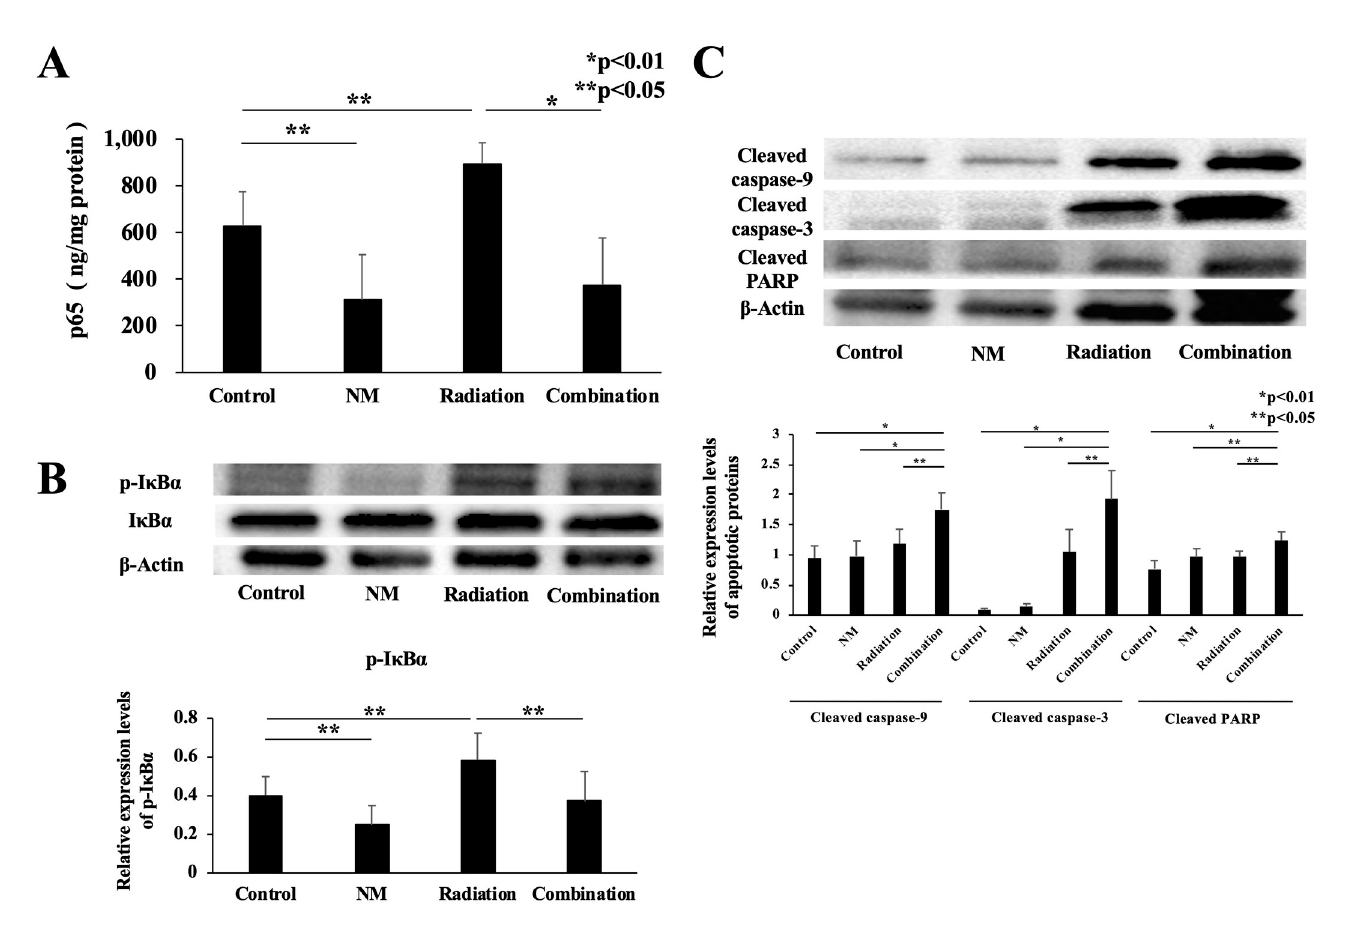
Fig 8. NF- κ B and apoptotic signals in vivo . (A) p65 concentration in the excised tumors significantly increased in the radiation group compared with that in the control group (893.6 ± 91.0 ng/mg protein vs. 628.5 ± 146.1 ng/mg protein, p < 0.05). p65 expression in the combination group was lower than that in the radiation group (375.93 ± 201.3 ng/mg protein vs. 893.6 ± 91.0 ng/mg protein, p < 0.01). (B) Western blotting results revealed that the expression level of phosphorylated I κ B α decreased in the combination group compared with that in the radiation group (p < 0.05). (C) The expression levels of apoptotic proteins in the combination group were higher than those in the other